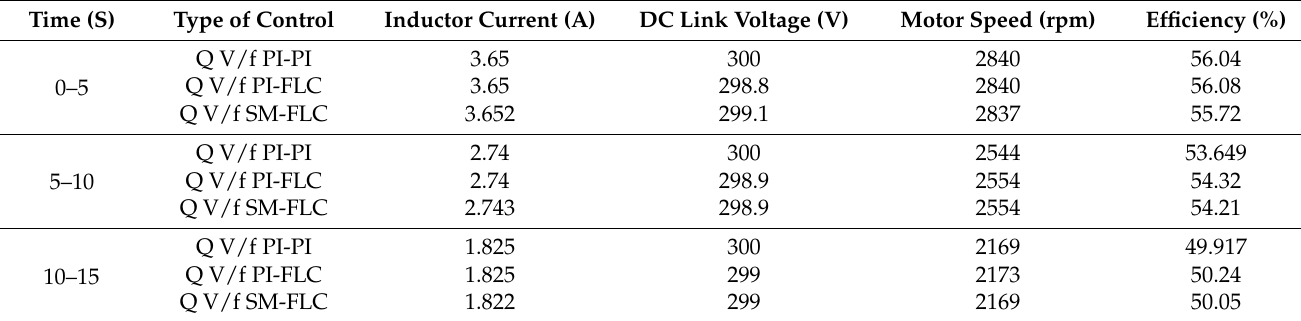
Table 5. Simulation results for Q V/f PI-FLC and Q V/f SM-FLC compared to Q V/f